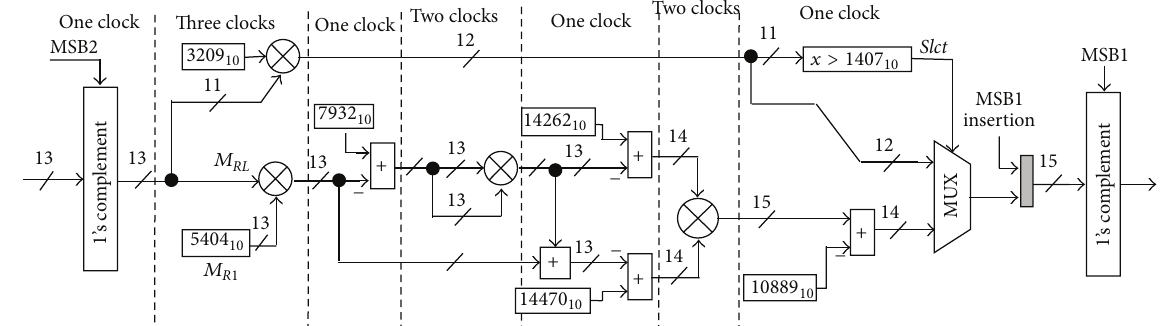
Figure 13: Pipelined version of the proposed architecture.